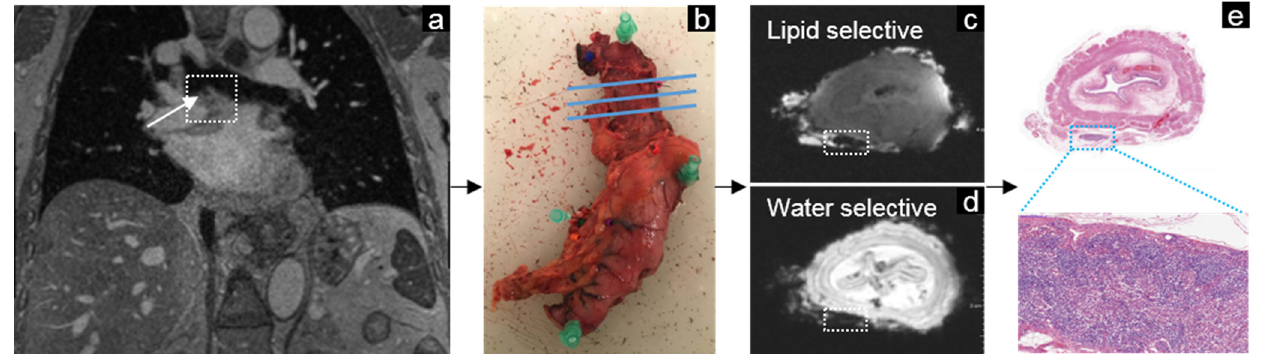
Figure 6. Example of the workflow in esophageal cancer. Lymph nodes were identified on the in vivo MRI after neoadjuvant chemoradiotherapy ( a ). Nodes could be matched using corresponding anatomical landmarks to the surgical specimen ( b ) and ex vivo MRI ( c , d ). The lipid-selective ( c ) and water-selective ( d ) ex vivo MRI guided the pathologist towards the lymph nodes for histopathological analysis of each node with hematoxylin and eosin staining ( e ). The white dashed lined box on the ex vivo MRI ( c , d ) and pathology ( e ) contains a healthy lymph node with USPIO contrast (the USPIO surgery interval was 1 day). Therefore, the lymph node lost its signal intensity on the water-selective